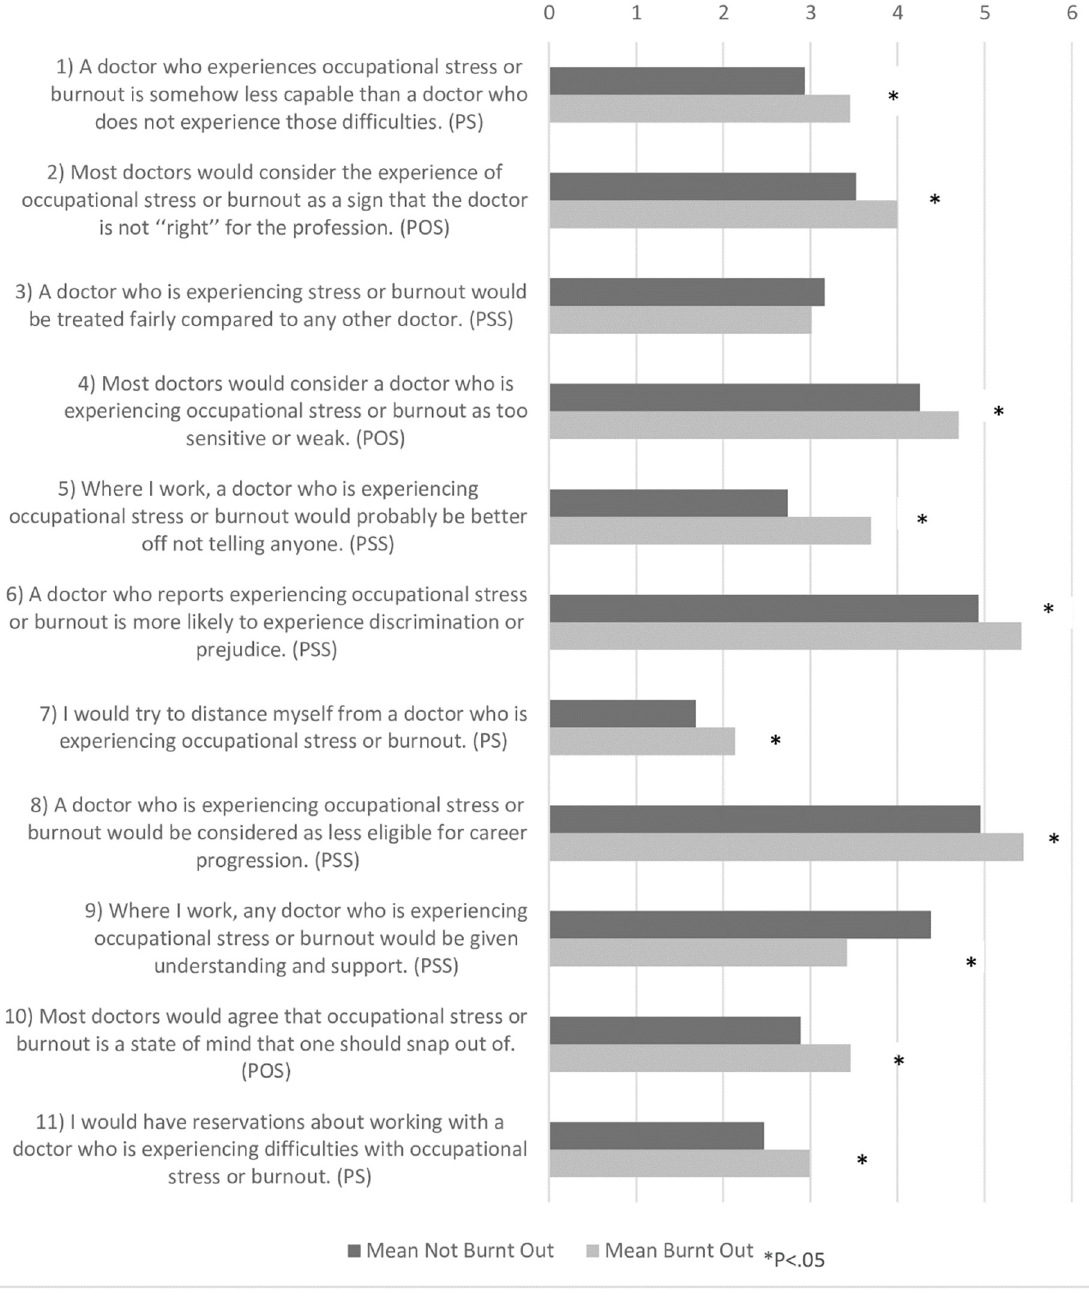
Fig 1. Comparison of stigma by burnout. PS: Personal stigma, POS: Perceived other stigma, and PSS: Perceived structural stigma.